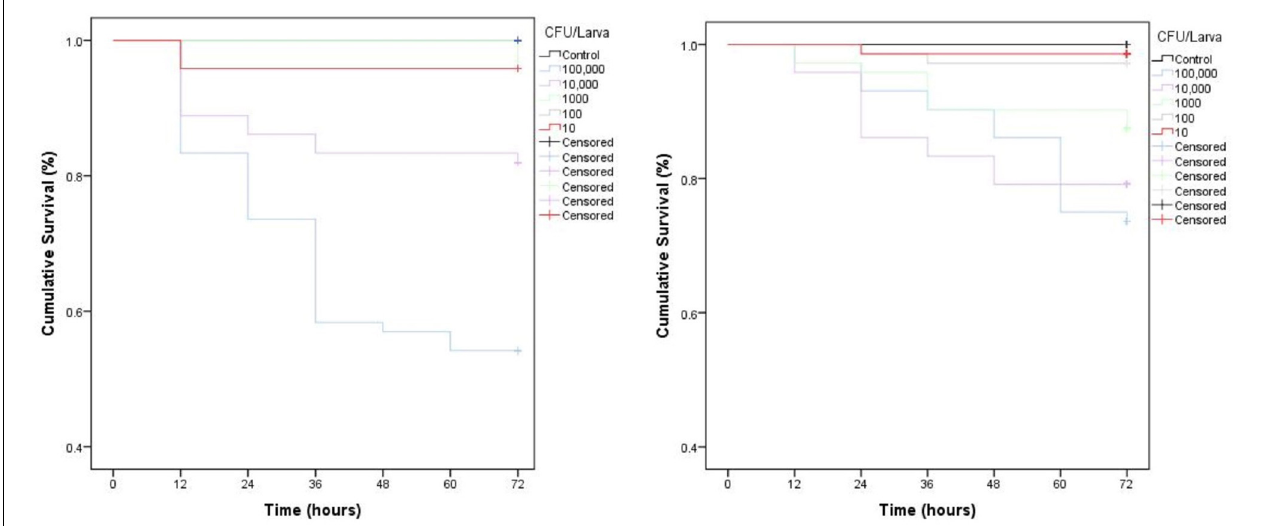
FIGURE 5 | Kaplan–Meier survival distributions for dose dependent challenges of JBCNJ055 and JBFR014. ATCC 13124 is avirulent at all dosage levels. Three repeats of each experiment were pooled. Results were collated as % survival. Strikethrough indicates censored data (unaffected larvae). All levels of infection data are significant ( P < 0.001) [Mantel (cox) log rank test] for both isolates investigated indicating larval survival is based upon the number of bacteria injected.